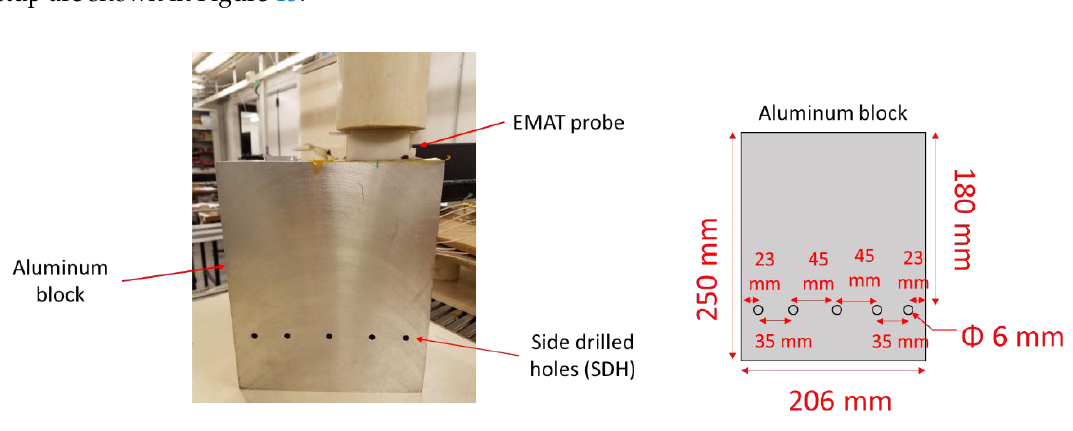
Figure 15. Experimental setup and geometric characteristics of the aluminum block used for the echo measurements on side-drilled holes.